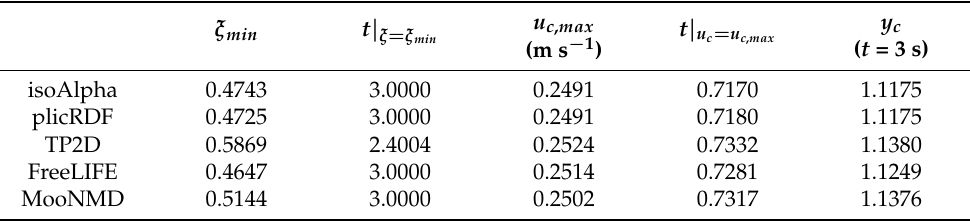
Table 6. Benchmark results for the C2 case for both isoAlpha and pliRFD method compared with Ref. [29].